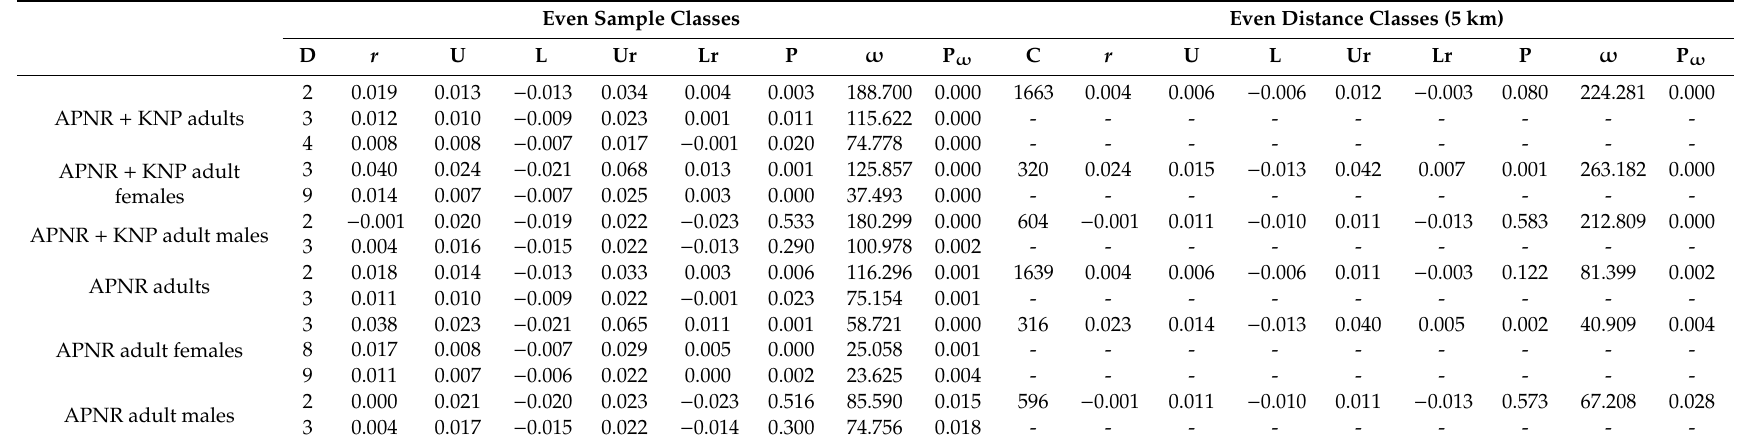
Table 2. Summary of the main results of spatial autocorrelation analyses using either even sample classes (with at least 100 pairwise comparisons for each distance interval) or even distance classes of 5